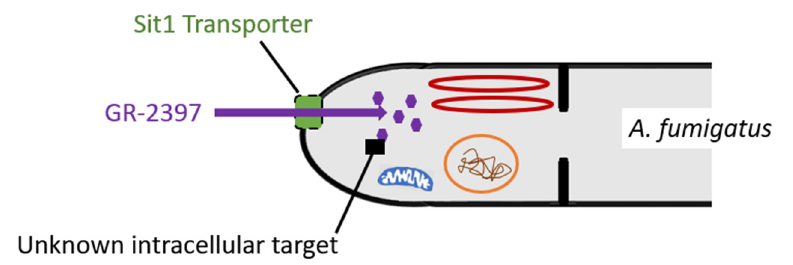
Figure 2. Transport and mechanism of action of GR-2397.